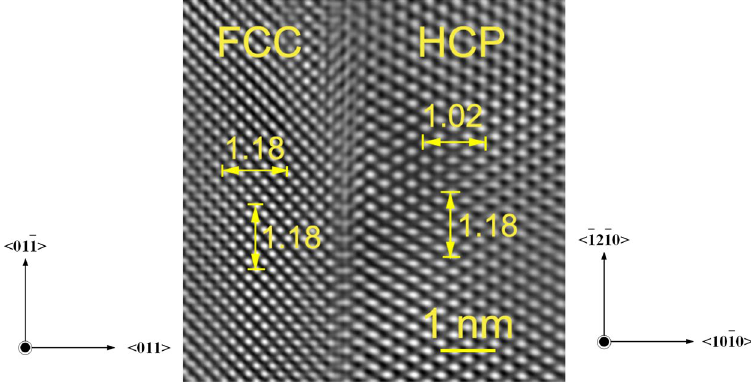
Figure 7. Fourier-filtered HRTEM image of 011 1010 { } { }